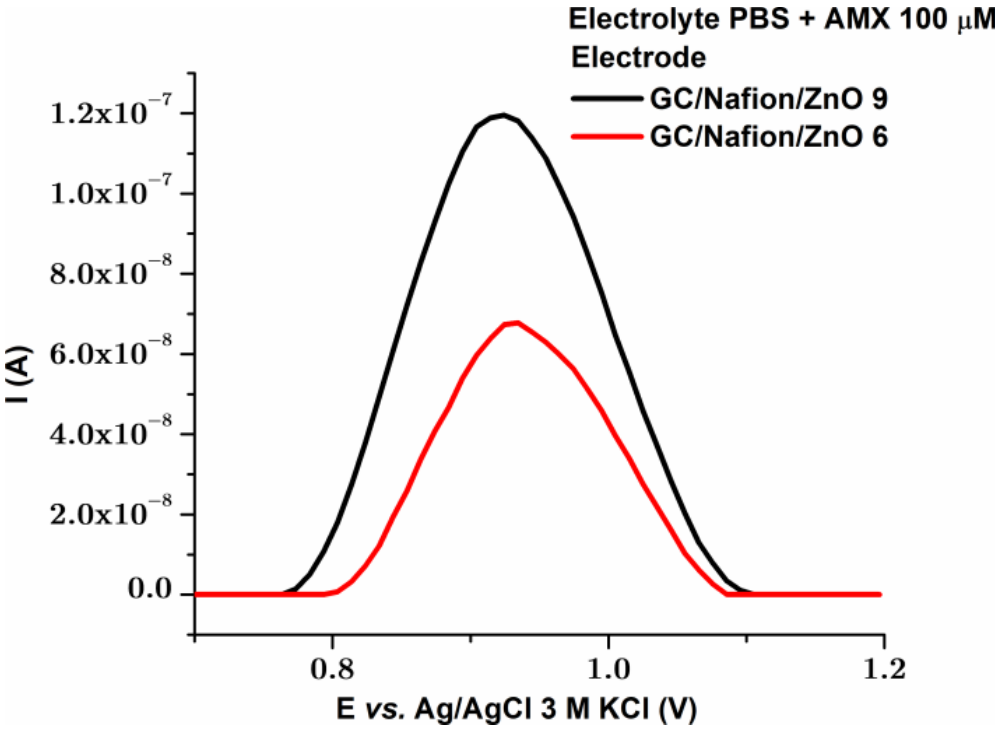
Figure 7. DPV curves in PBS solution + AMX 100 μM corresponding to GC/Nafion/ZnO 9 and GC/Nafion/ZnO 6.